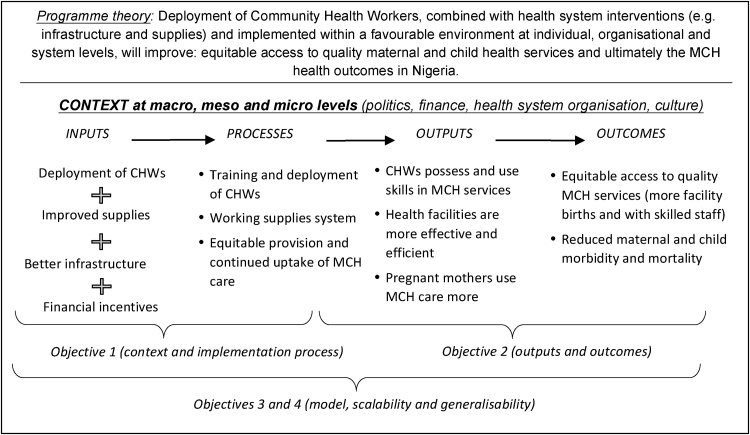
Conceptual framework for realist evaluation of CHW programme (Source: Mirzoev et al., 2016, pg5).